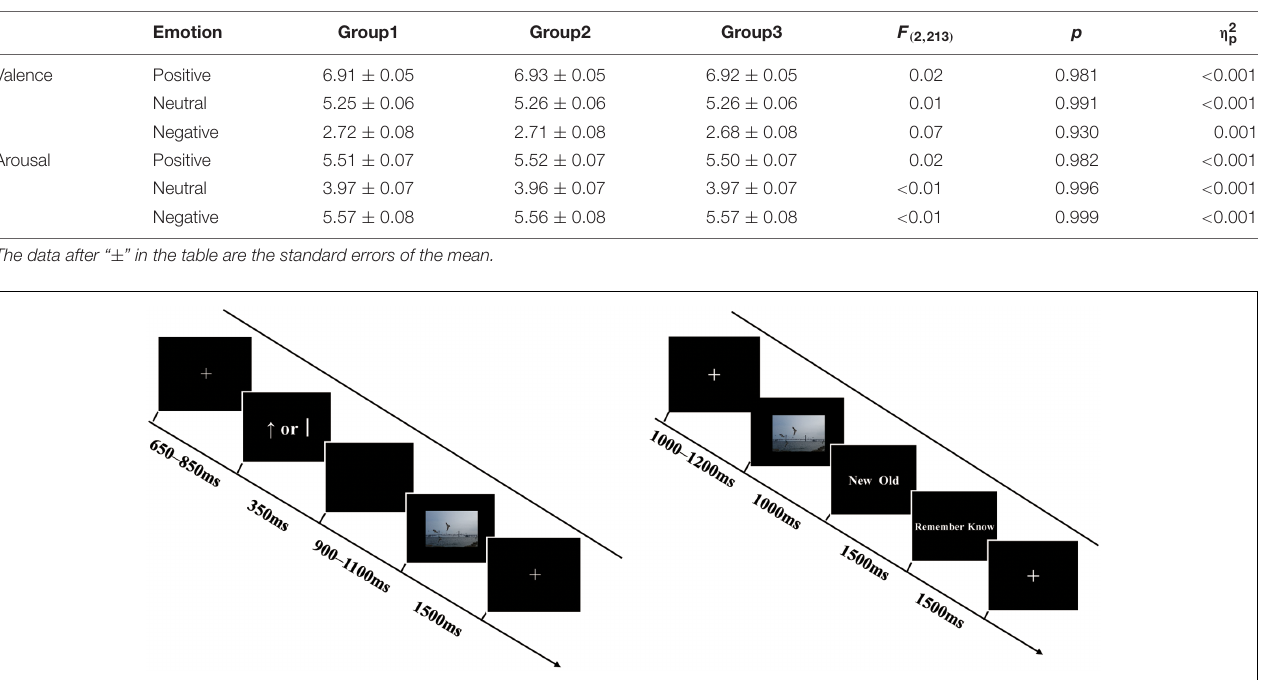
blink artifacts were corrected using a linear regression estimate (Picton et al., 2000; Hornberger et al., 2004; Wang et al., 2015). Impedances were kept below 5 k (cid:127) . EEG and EOG signals were band-pass filtered from 0.05 to 40 Hz. Trials with a